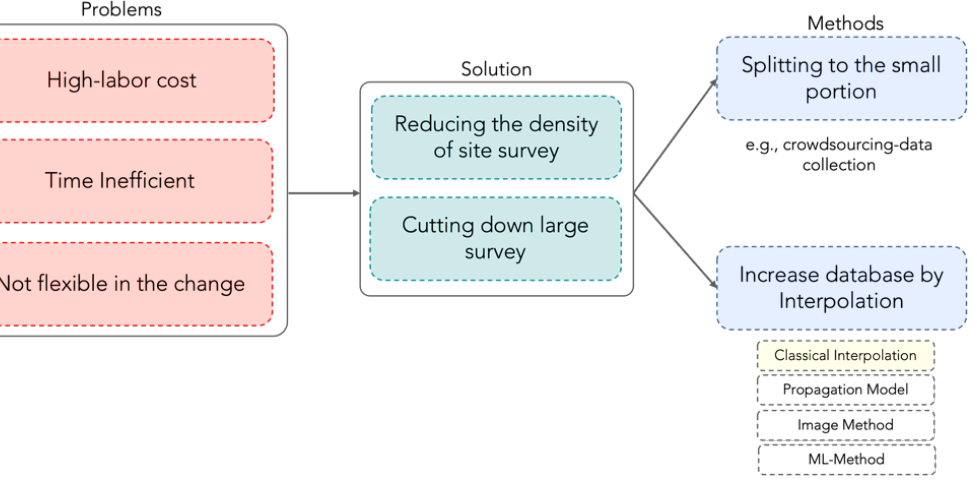
Figure 5. Challenges and prospective solutions of the fingerprint